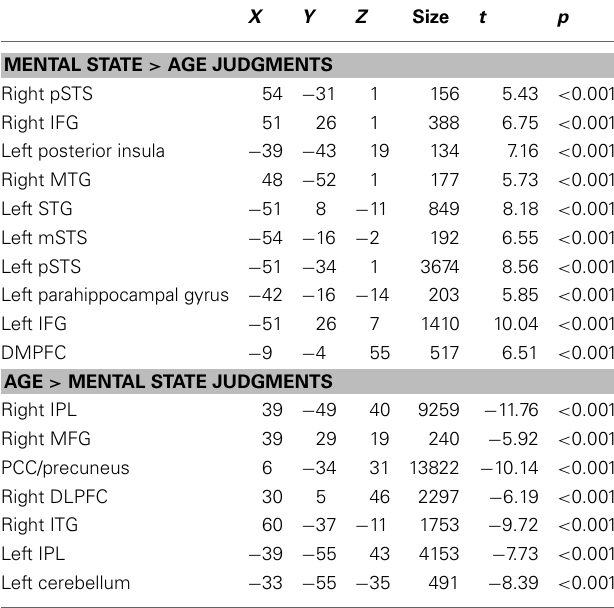
Table 2 | Activation in RMET-R at baseline.